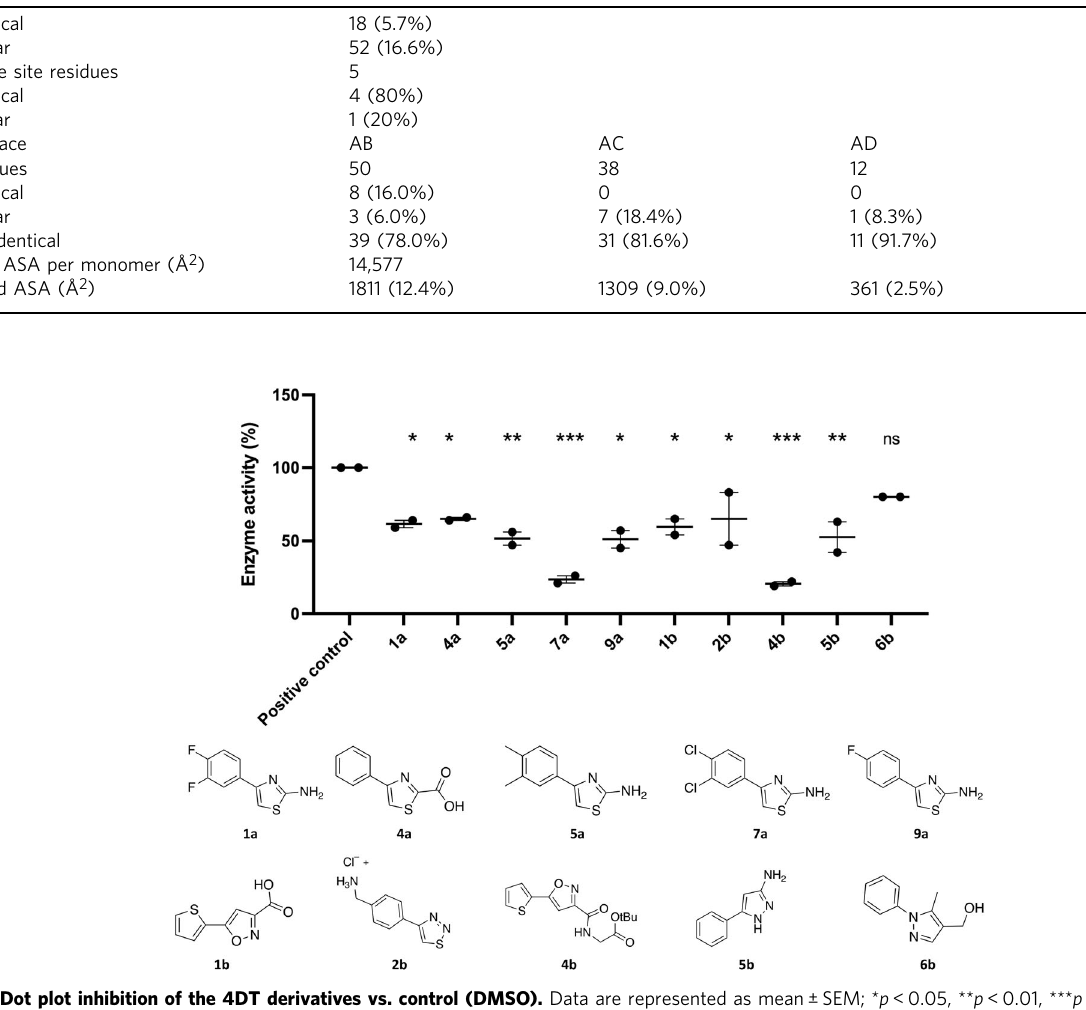
Table 2 Surface analysis with PISA online server 60 and sequence conservation across another malate dehydrogenase. Number of residues